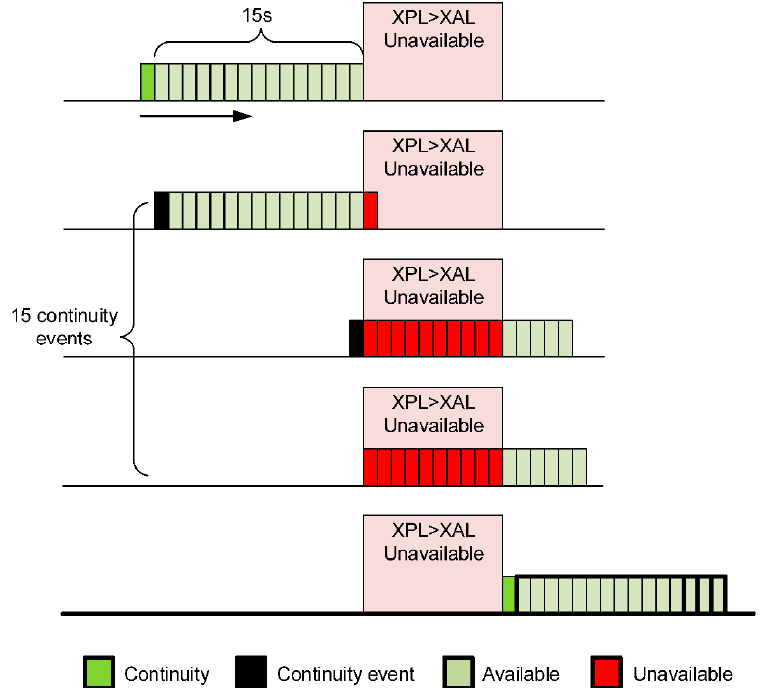
Figure 6. Using a 15-second sliding window to assess continuity risk. For a specific epoch, if the system is available at the beginning, and becomes unavailable for at least one second in the next 15 seconds (for example, the signal is lost for more than four seconds or the protection level exceeds the alarm threshold), then a continuity event occurs. If a service is unavailable within a second, this will result in 15 continuity events.